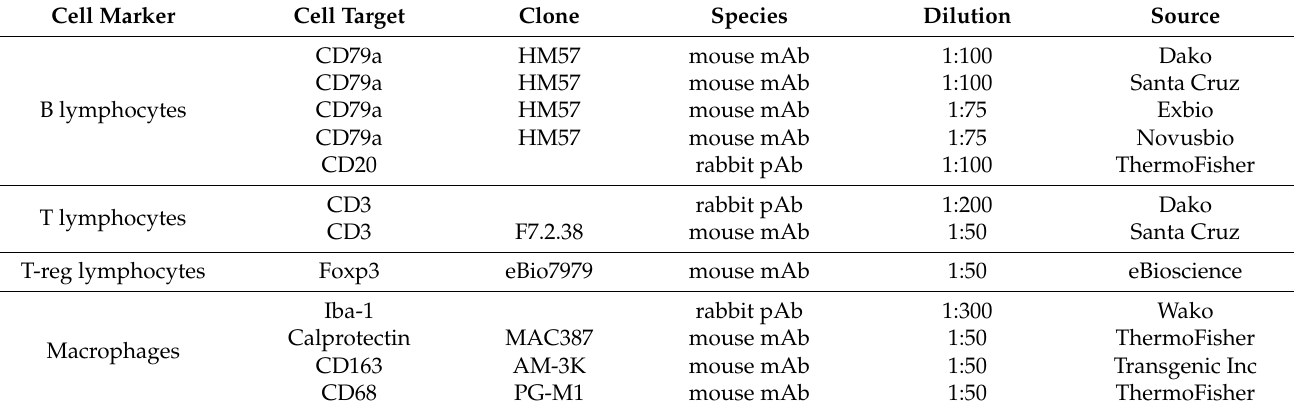
Table 1. The 12 anti-human monoclonal and polyclonal antibodies employed and their targets, clones, species of origin, dilution, and source. CD, cluster of differentiation; Foxp3, forkhead box P3; Iba-1, ionized calcium-binding adaptor molecule